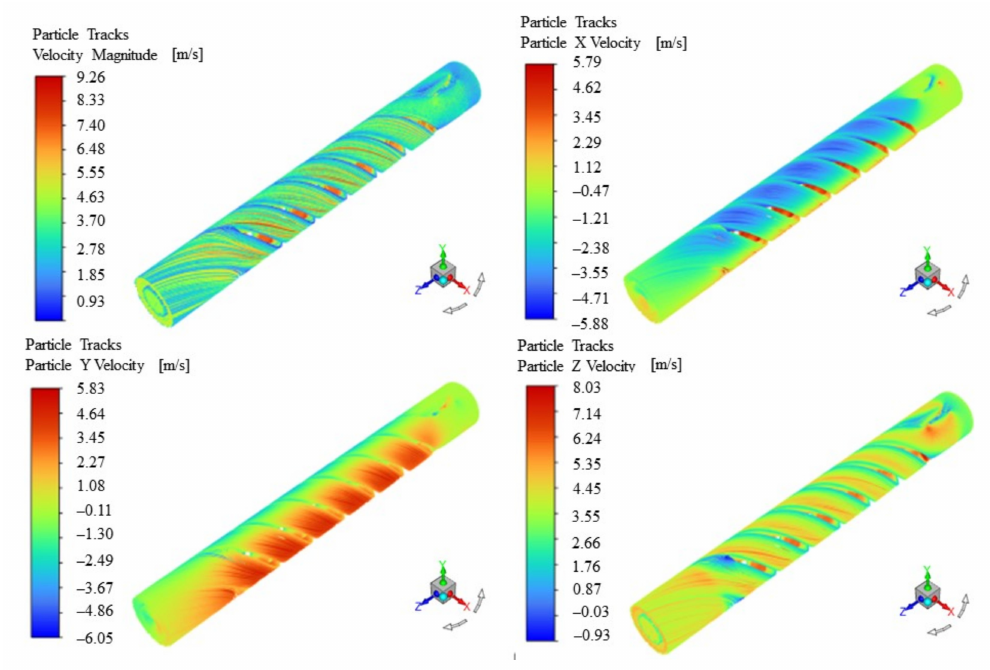
Figure 7. Velocity distribution of sand particles in a fixed pitch cyclone separator.